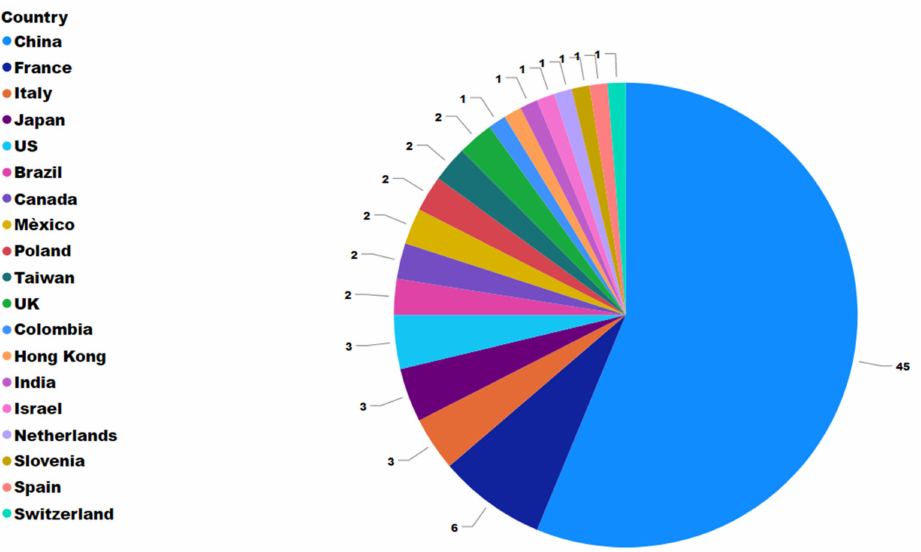
Figure 5. Country